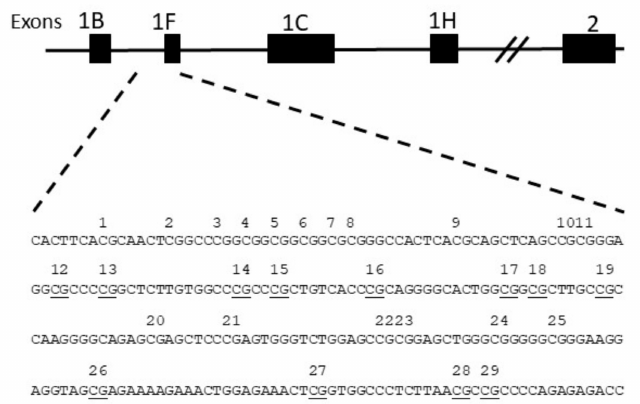
Figure 1. Scheme of the human NR3C1 gene analyzed by bisulfite pyrosequencing. The 5 (cid:48) - end of the human NR3C1 gene contains multiple first exons with multiple transcriptional start sites and mRNA splice variants. The region analyzed by bisulfite pyrosequencing contains 29 CpGs and encompasses exon 1-F, which is the human homolog of the rat exon 1–7, previously shown to be di ff erentially methylated